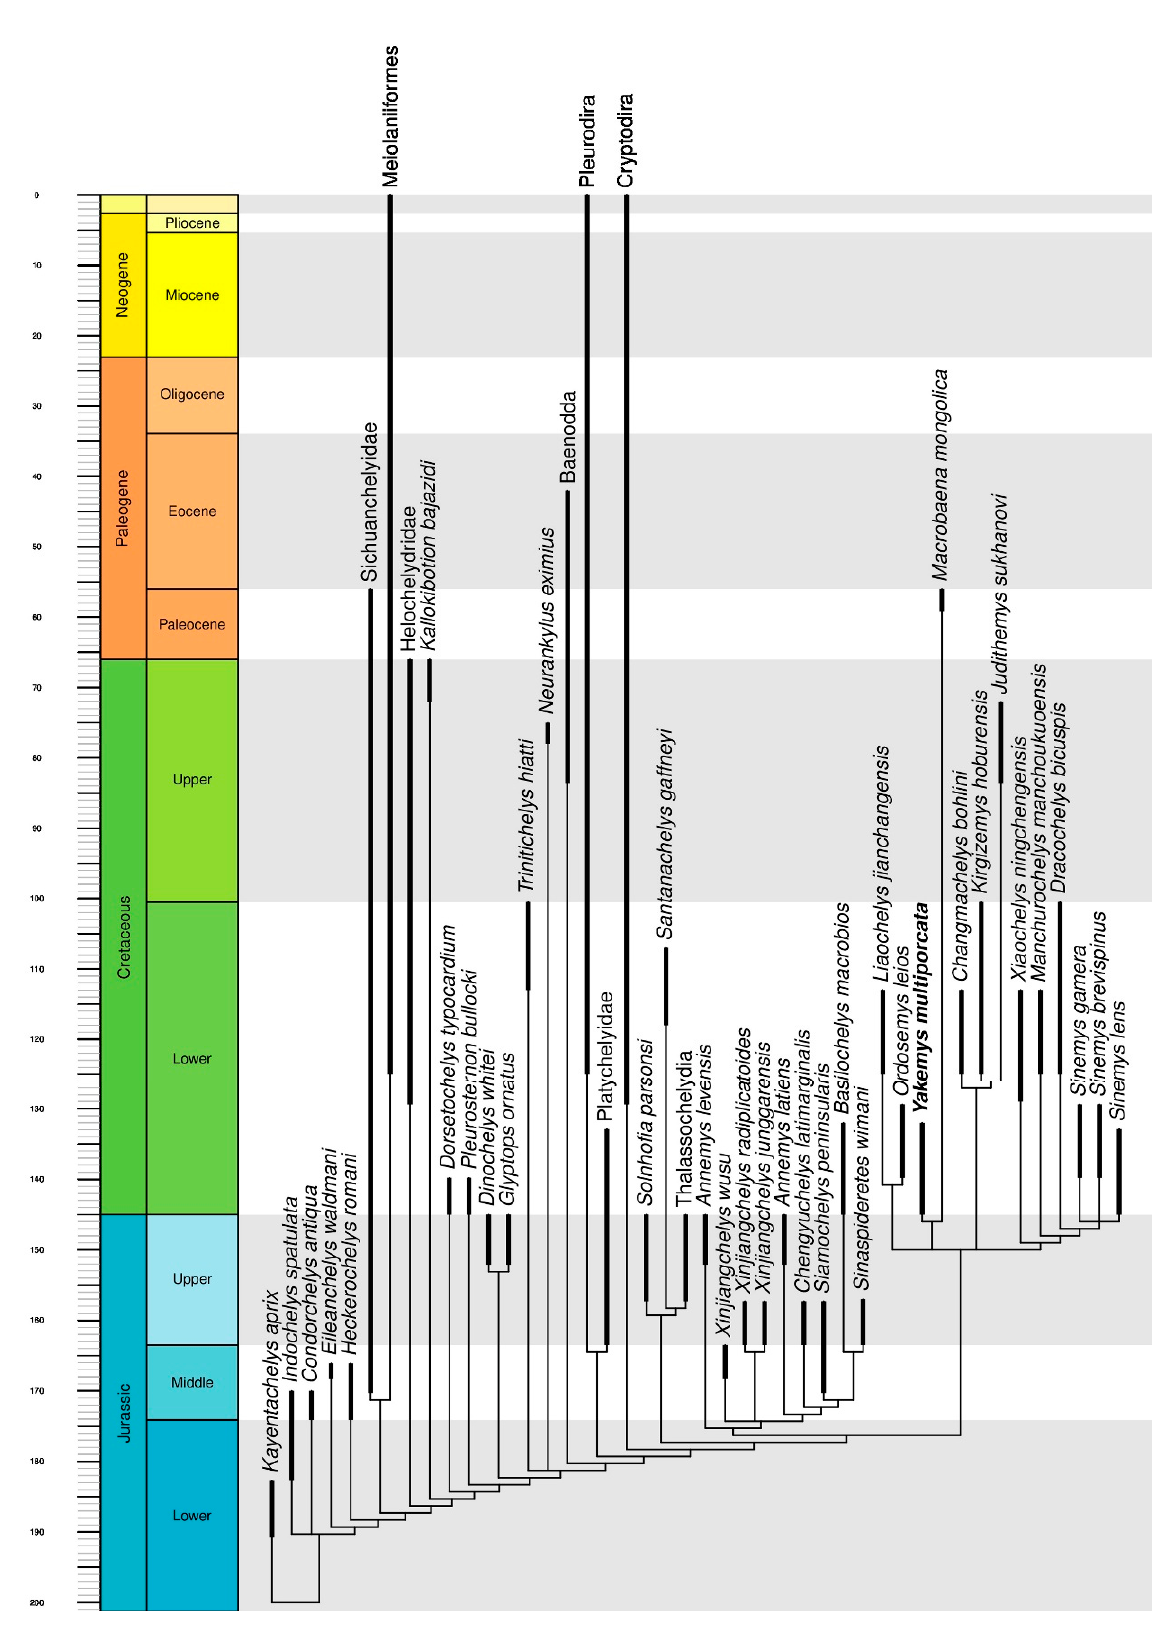
Figure 4. Simplified Adams consensus cladogram obtained from the constrained phylogenetic analysis.